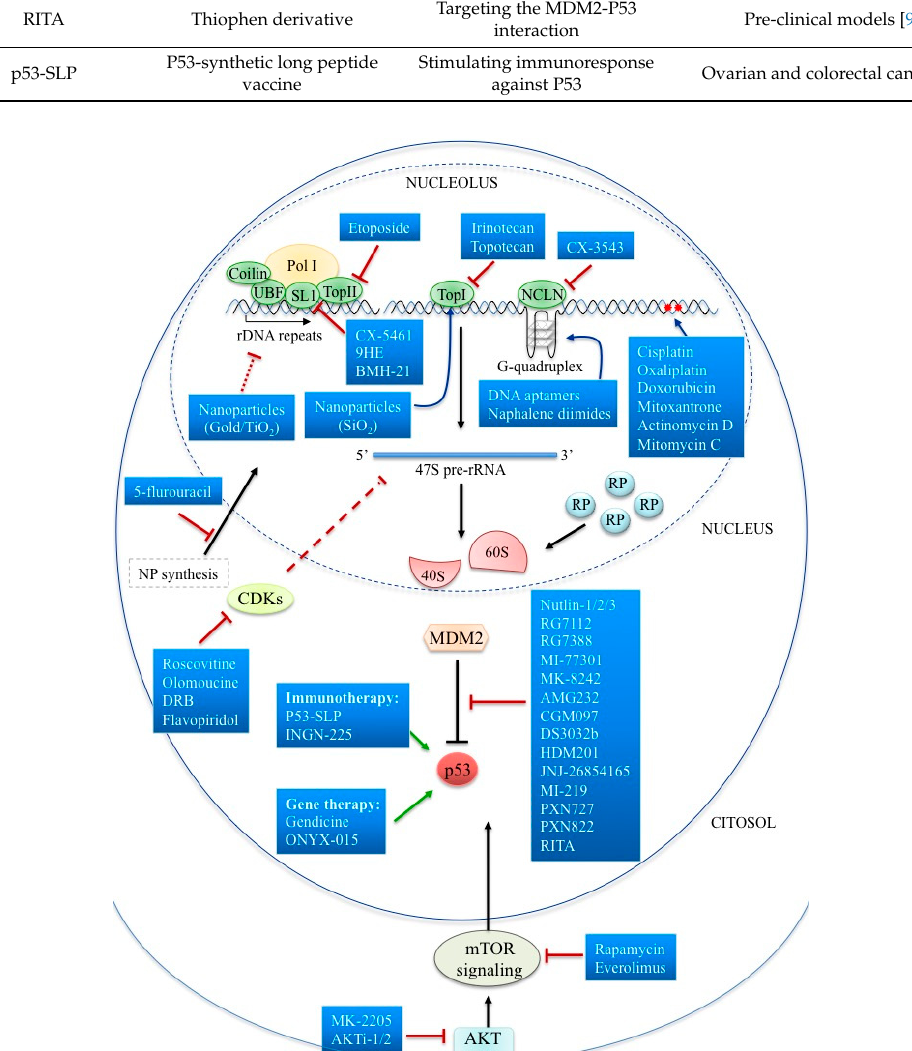
Figure 2. Targeting Nucleolar Function in Cancer Therapeutics. Schematic representation of anti-cancer drugs targeting nucleolar structures and/or functions.